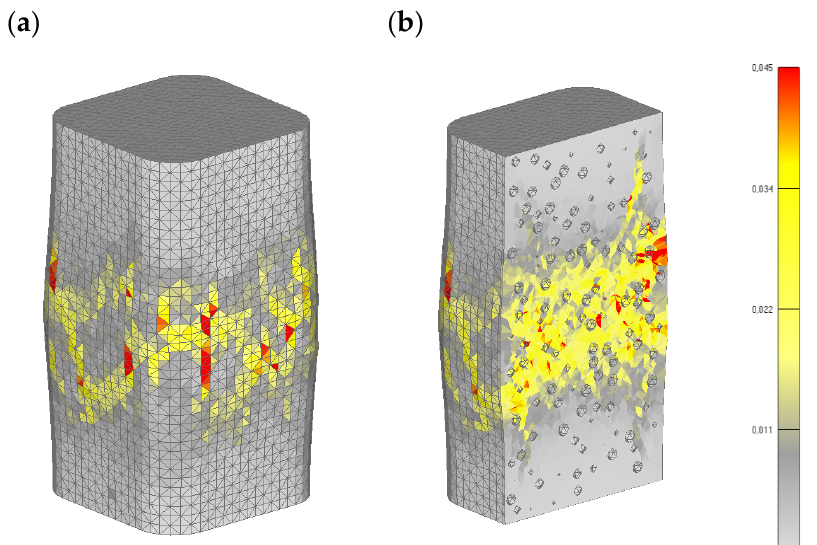
Figure 7. ( a ) Typical failure mode of R 30 and ( b ) Internal damage distribution in mortar.